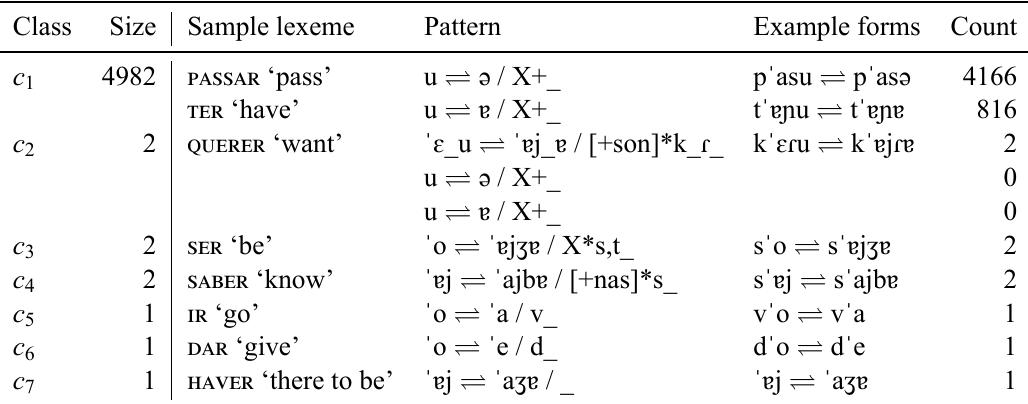
Table 9: Classes of PRS.IND.1SG for prediction of